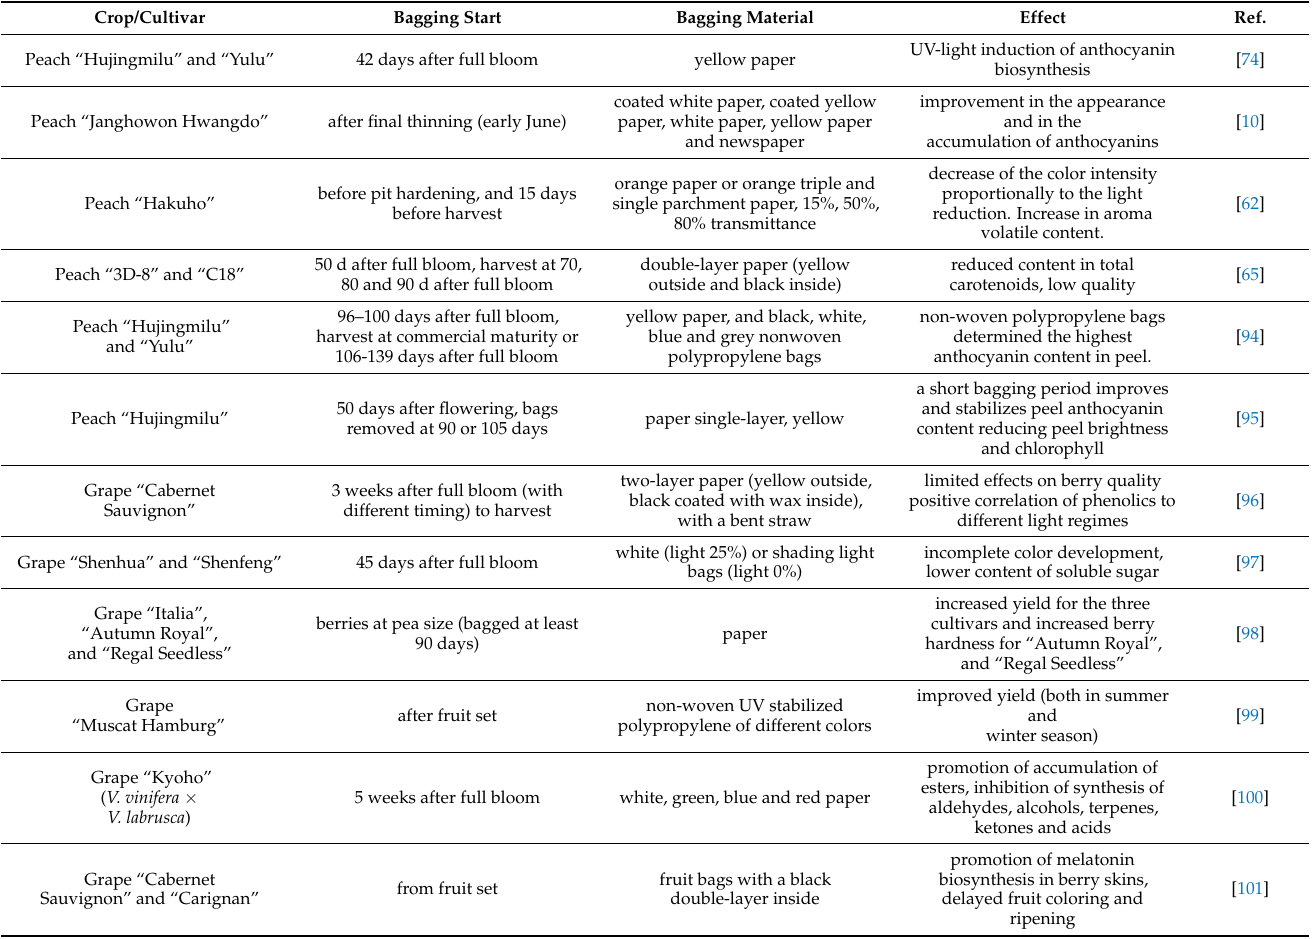
Table 4. The influence of bagging on color and quality of peach and grape